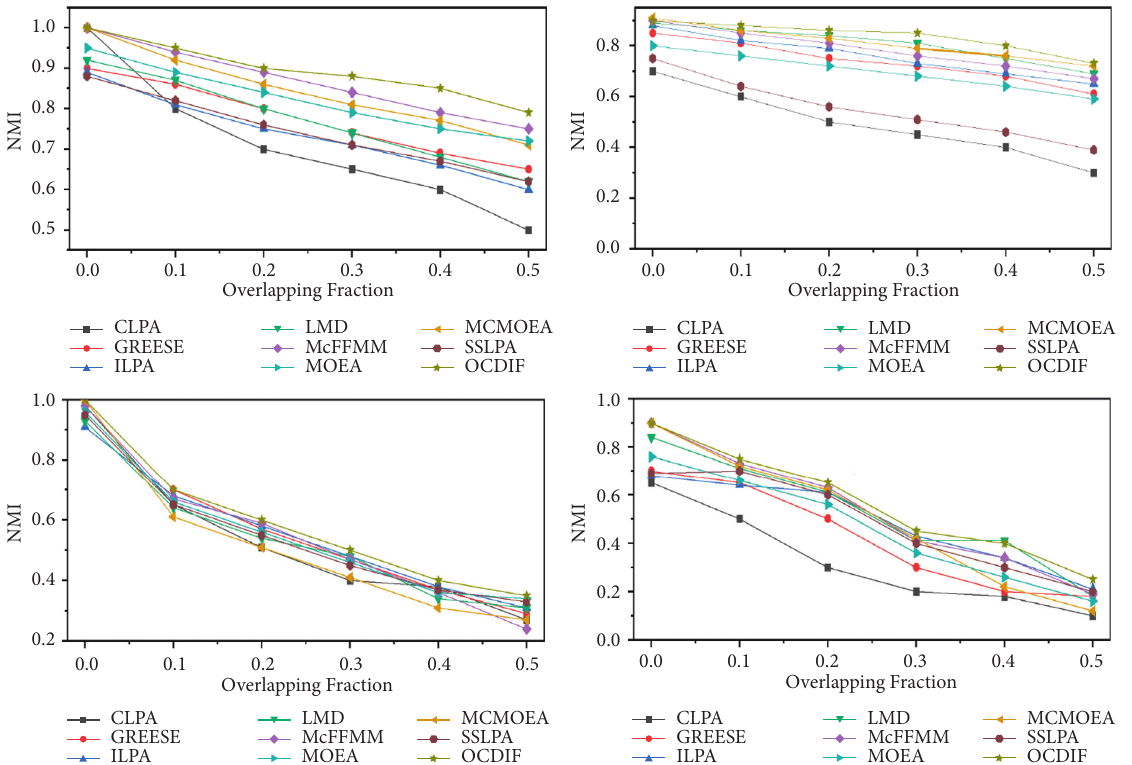
Figure 8: Experimental results on the synthetic network (N1, N2, N3,